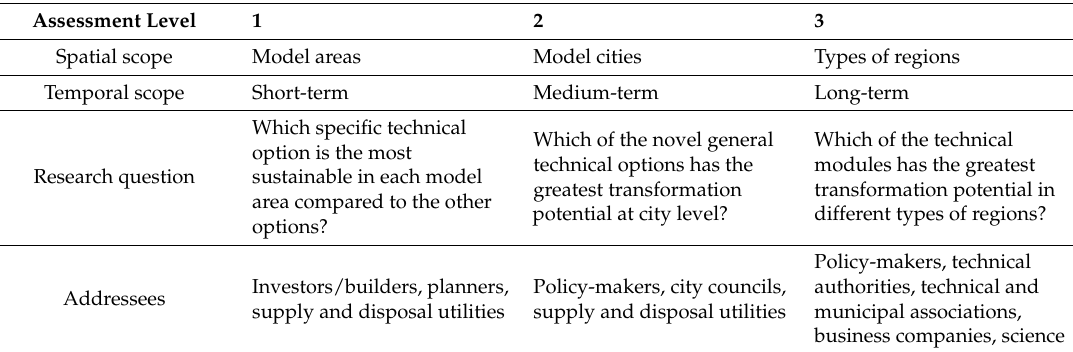
Table 3. Assessment framework